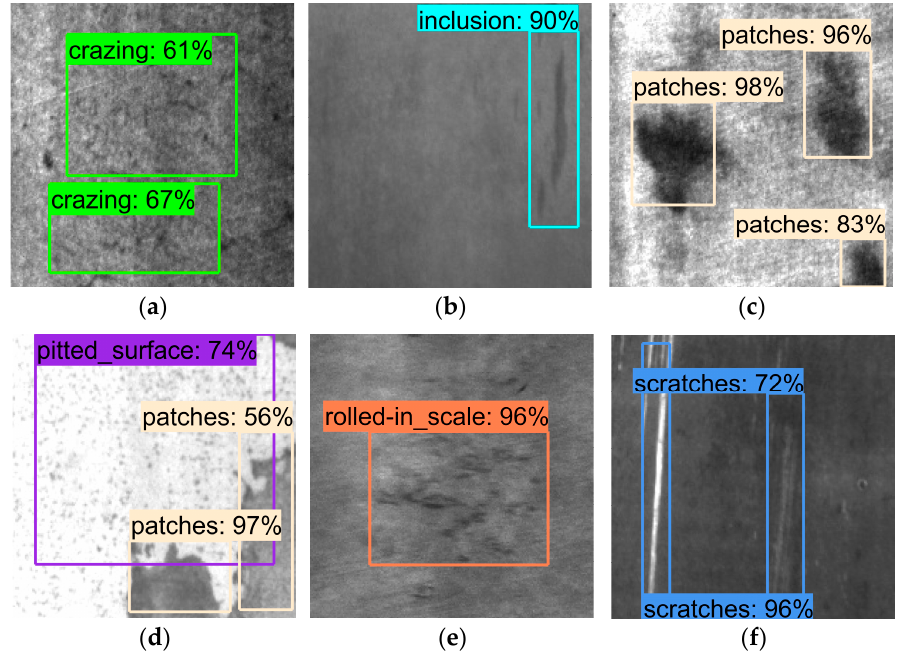
Figure 8. Example of DPN-Detector detection results on NEU-DET: ( a ) Cr; ( b ) In; ( c ) Pa; ( d ) PS; ( e ) RS and ( f ) Sc.